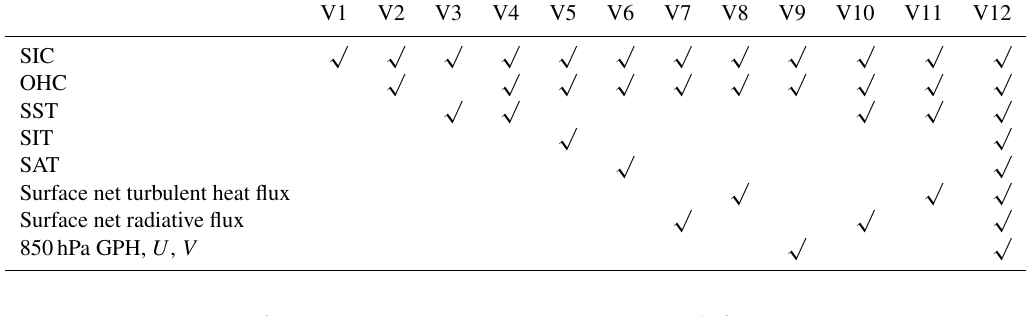
Table 1. Variable combinations in cross-validated experiments. V1 represents the no. 1 variable combination. included in the corresponding combination.